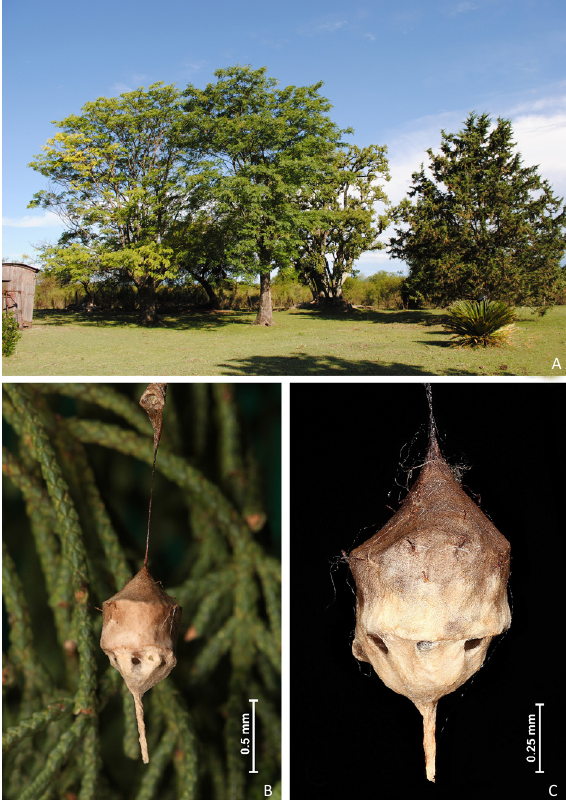
Image 3. Collecting site and egg sac of Iviraiva pachyura . A - Site where Iviraiva pachyura was found, a rural environment with the presence of non-native trees such as Melia azedarach and Cupressus sp.; B - an egg sac in the foliage of a Cupressus sp. tree (FCE-Ar 4818); C - detail of an egg sac (FCE-Ar 4818). © A - Álvaro Laborda; B,C - Bruno